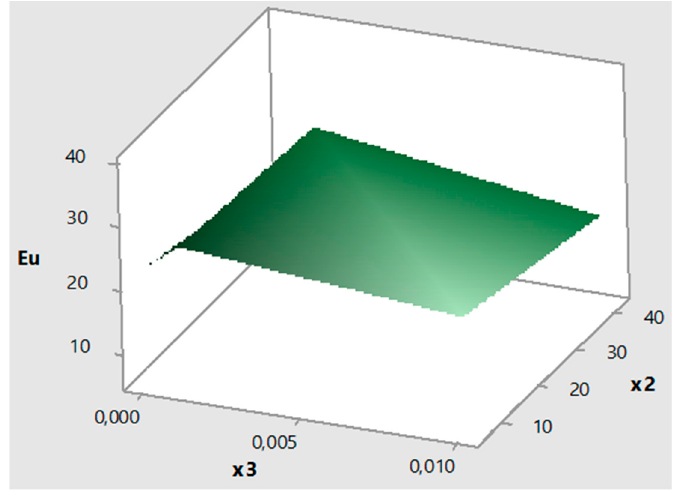
Figure 12. Surface plot of E u 50 vs. x2 and x3.